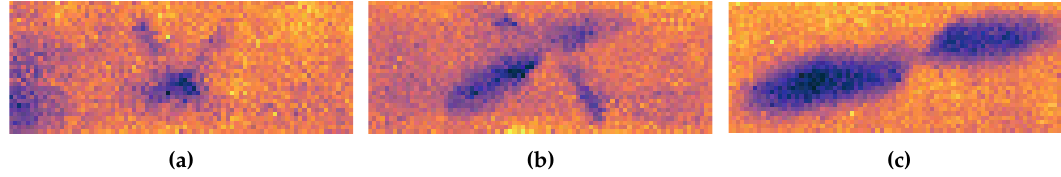
Figure 14. Images for the there considered defects. ( a ) Defect with 3J impact energy. ( b ) Defect with 6J impact energy. ( c ) Defect with 9J impact